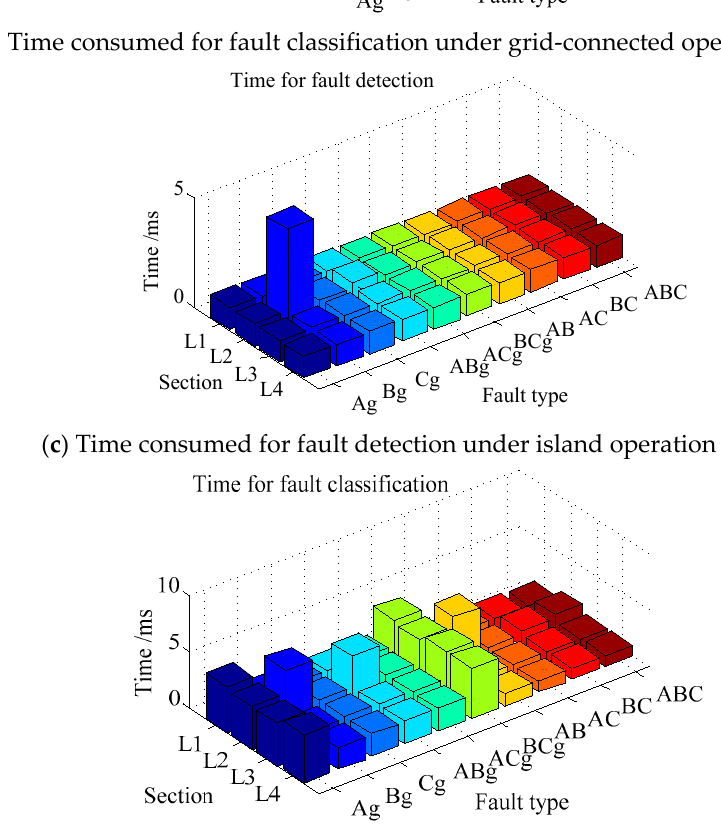
Figure 12. Fault simulation results of a microgrid system.